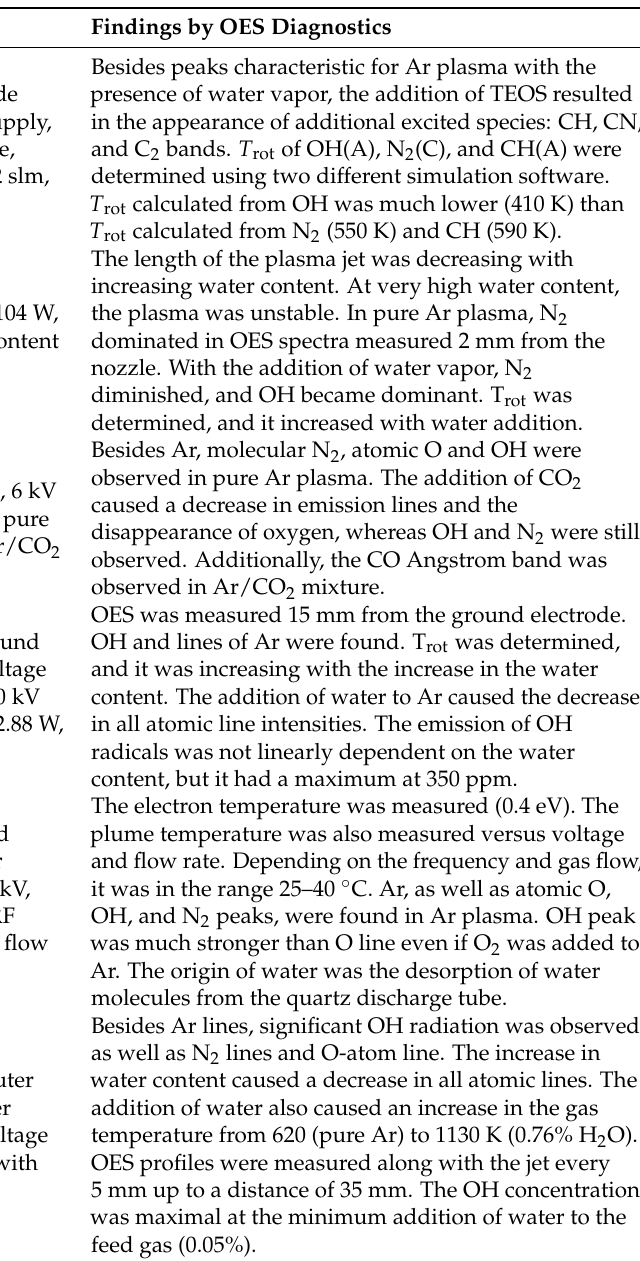
Table 1. T Summary of characterization of APPJ by